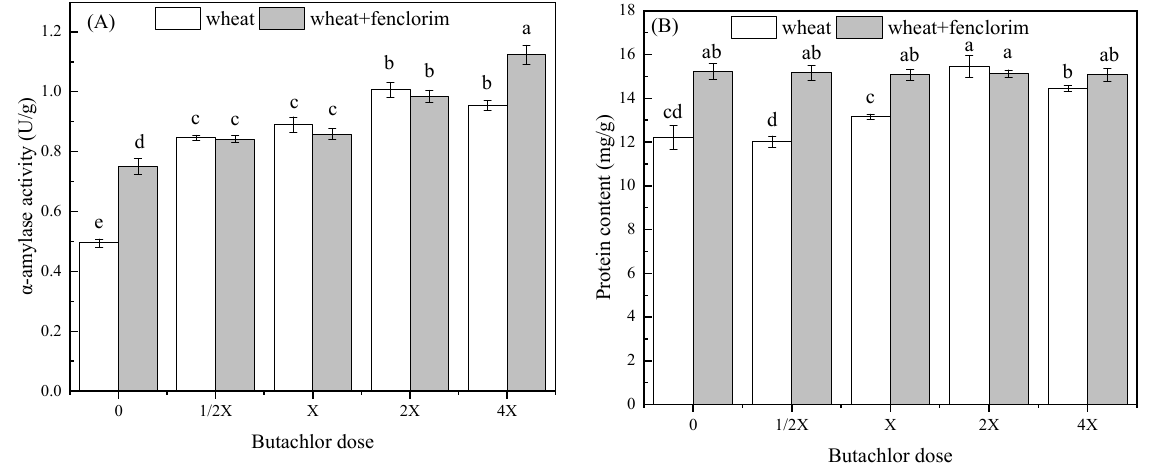
Figure 3. Activity of α -amylase ( A ) and protein content ( B ) in wheat seeds pre-soaked 6 h in water or in 30 mg/L fenclorim solution sprayed with different butachlor doses at 24 h after treatment. X represents the recommended field dose of butachlor 1350 g a.i. ha − 1 . Each point is the mean ± SE of twice-repeated experiments, each containing four replicates. Bars designated by different lowercase letters are significantly different according to Fisher’s protected LSD at p ≤ 0.05.